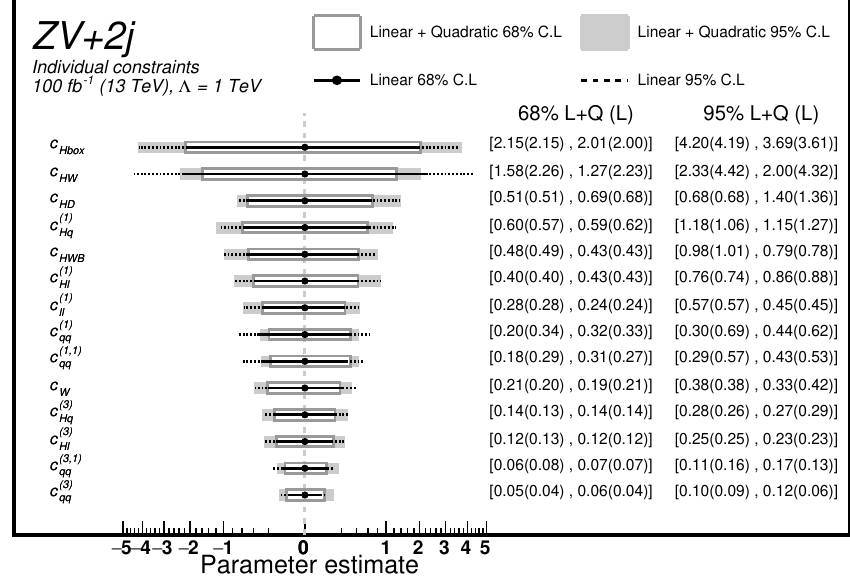
Figure 4 . Individual expected constraints on Wilson coefficients from the VBS ZV+2j channel in the semileptonic final state. The solid points represent the SM expectation. Solid (dashed) lines indicate the 68% (95%) confidence intervals obtained including only terms linear in the Wilson coefficients in the signal predictions. Open (filled) boxes indicate 68% (95%) confidence intervals obtained including both linear and quadratic EFT components. The QCD induced EFT dependence was included when relevant. Note that the constraints shown in this figure neglect effects due to the main background for this final state, i.e. Z+jets Drell-Yan